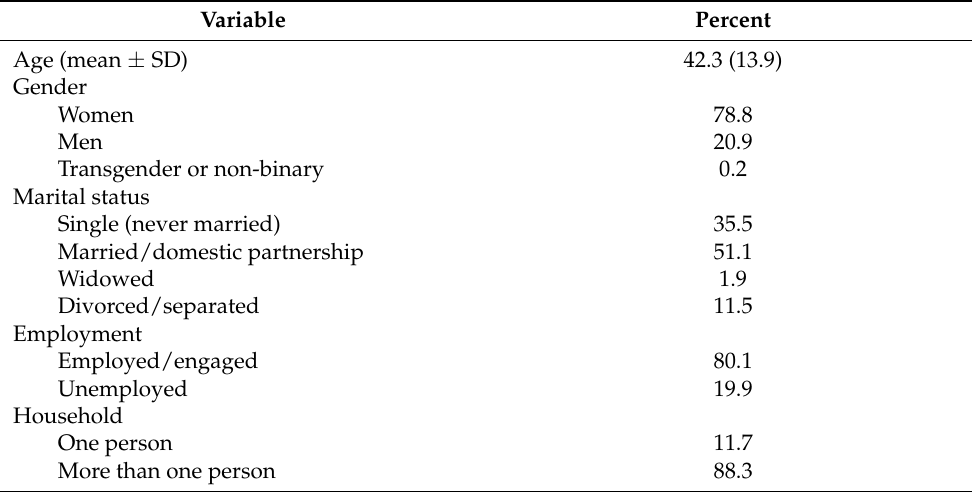
Table 1. Demographic characteristics of the